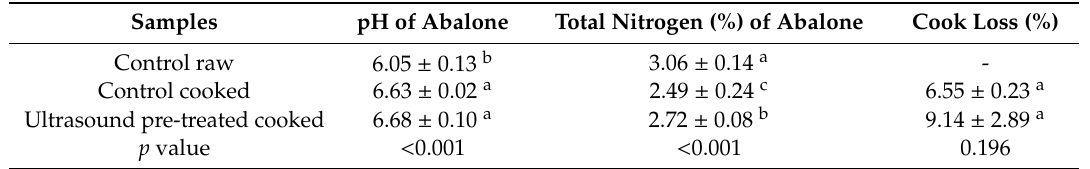
Table 1. pH, total nitrogen content (%), and cook loss (%) for control, and ultrasound pre-treated cooked p¯aua.